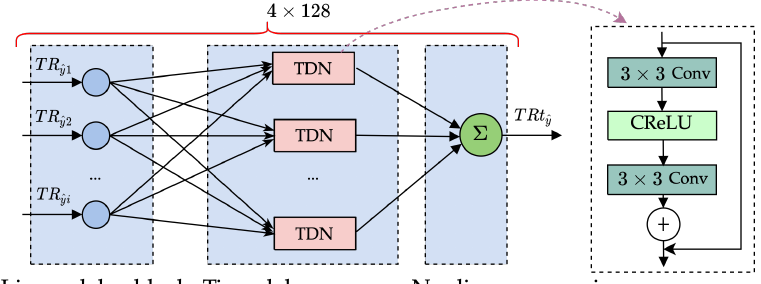
Figure 12. Network structure composition of